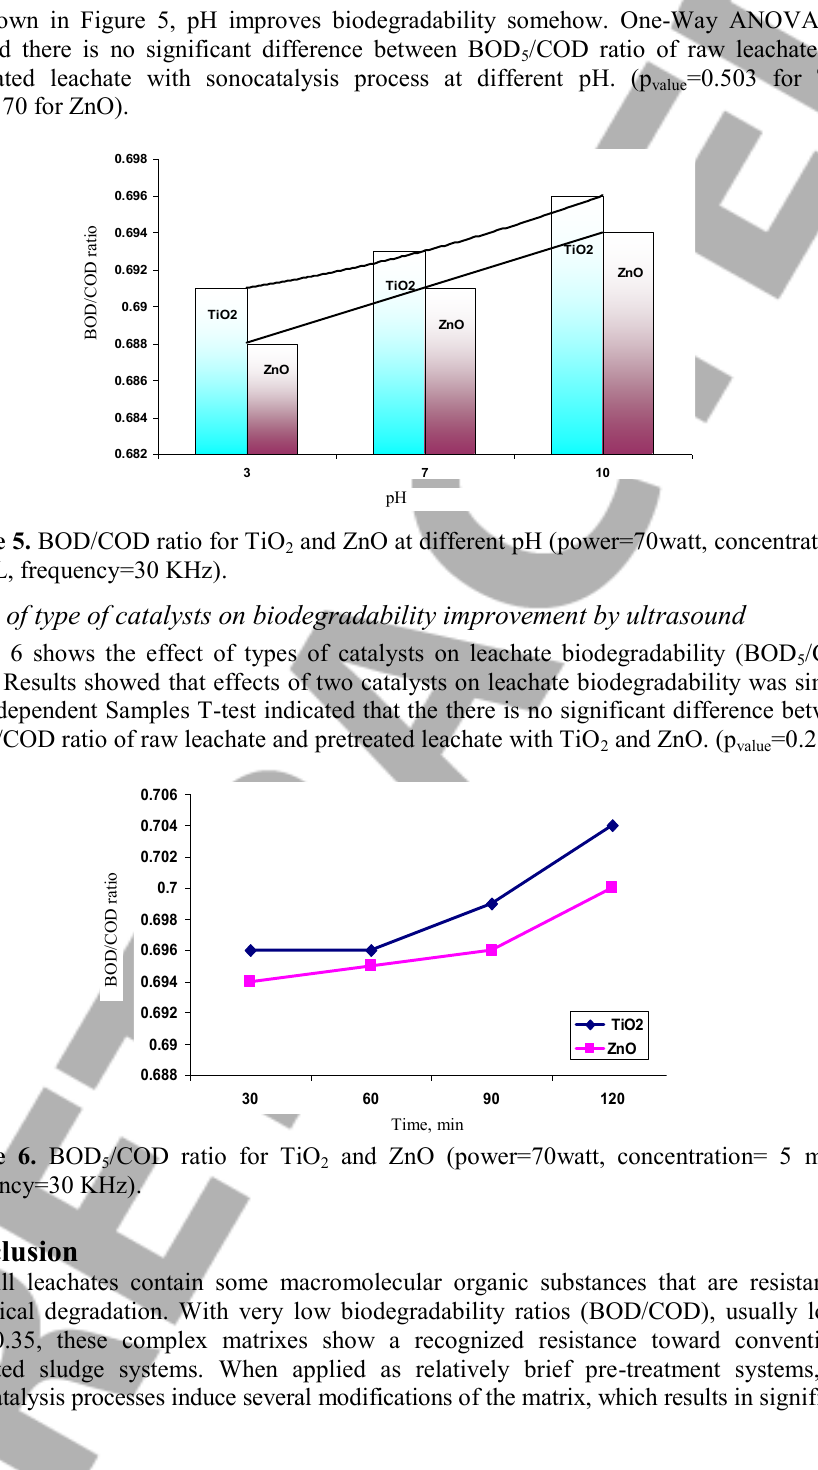
and ZnO (power=70watt, concentration= 5 mg/L, 2